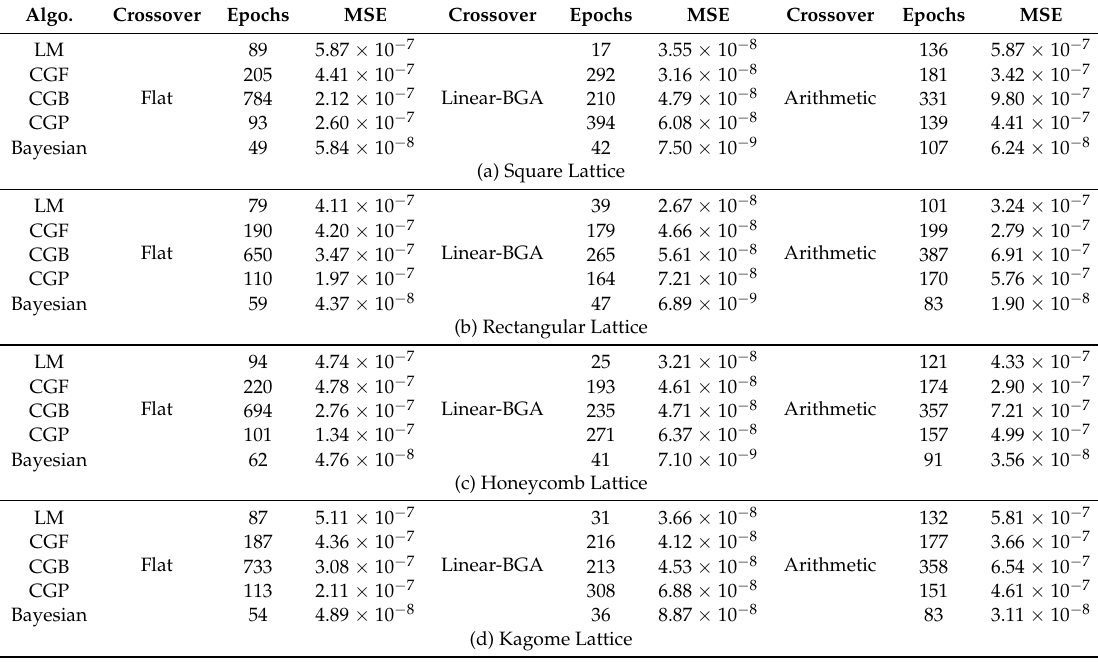
Table 1. Comparison of ANN’s training algorithms with multiple GA